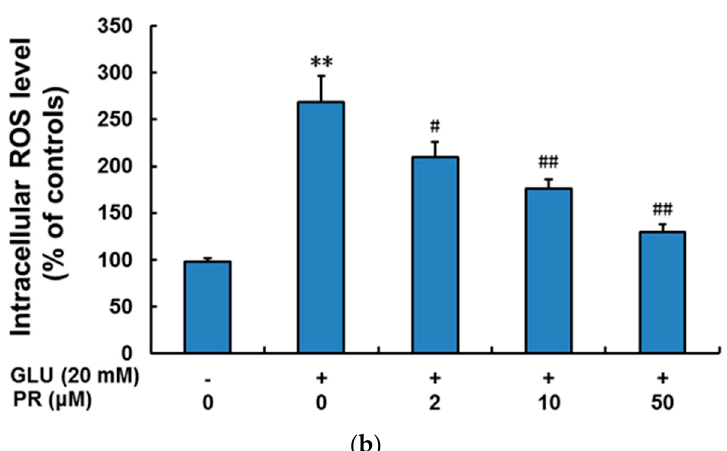
Figure 2. The neuroprotective effect of puerarin against the glutamate-induced reactive oxygen species (ROS) generation in the differentiated Y-79 cells. Cells were pre-treated with puerarin (0, 2, 10 and 50 μ M) for 24 h and then exposed to 20 mM glutamate for 6 h. After treatment, cells were incubated with dichloro-dihydro-fluorescein diacetate (DCFH-DA) (10 μ M) at 37 °C for 30 min in dark. ( a ) Representative microphotographs of fluorescence staining; ( b ) the relative fluorescence intensity was analyzed by flow cytometry. All data were expressed as mean ± SD of three experiments and each experiment included triplicate repeats. ** p < 0.01 vs. control group; # p < 0.05, ## p < 0.01 vs. glutamate-treated group. GLU: glutamate, PR: puerarin.